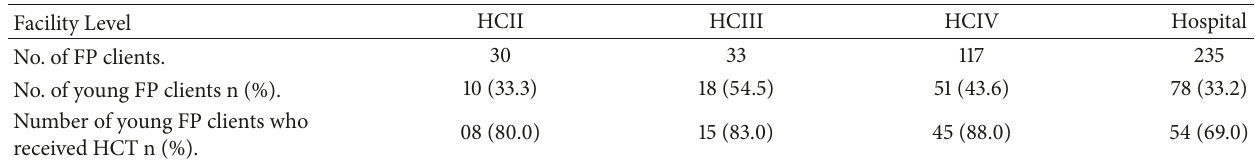
Table 3: Proportion of young family planning clients who received HIV counseling and testing between June and August 2016 in Mbarara Municipality. Facility Level HCII HCIII HCIV Hospital No. of FP clients. 30 No. of young FP clients n (%). Number of young FP clients who received HCT n